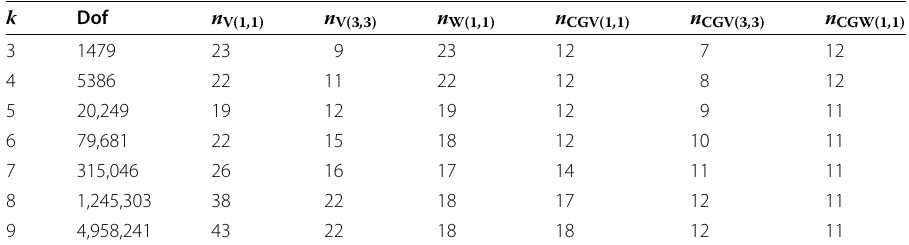
Table 1 Measured iteration numbers n for the stand-alone solver and n CG for the preconditioned CG method attained for the model problem (19) on the configuration depicted in Fig. 1 using a single element